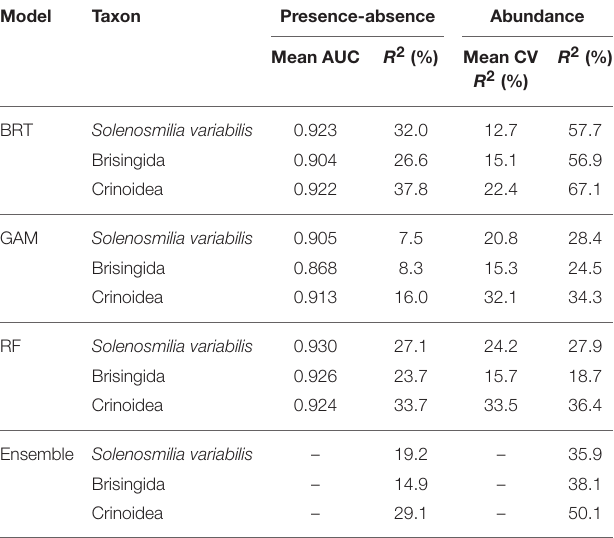
TABLE 4 | Comparison of performance statistics for four types of presence-absence and abundance models for Solenosmilia variabilis , Brisingida, and Crinoidea on seamounts of the Louisville Seamount